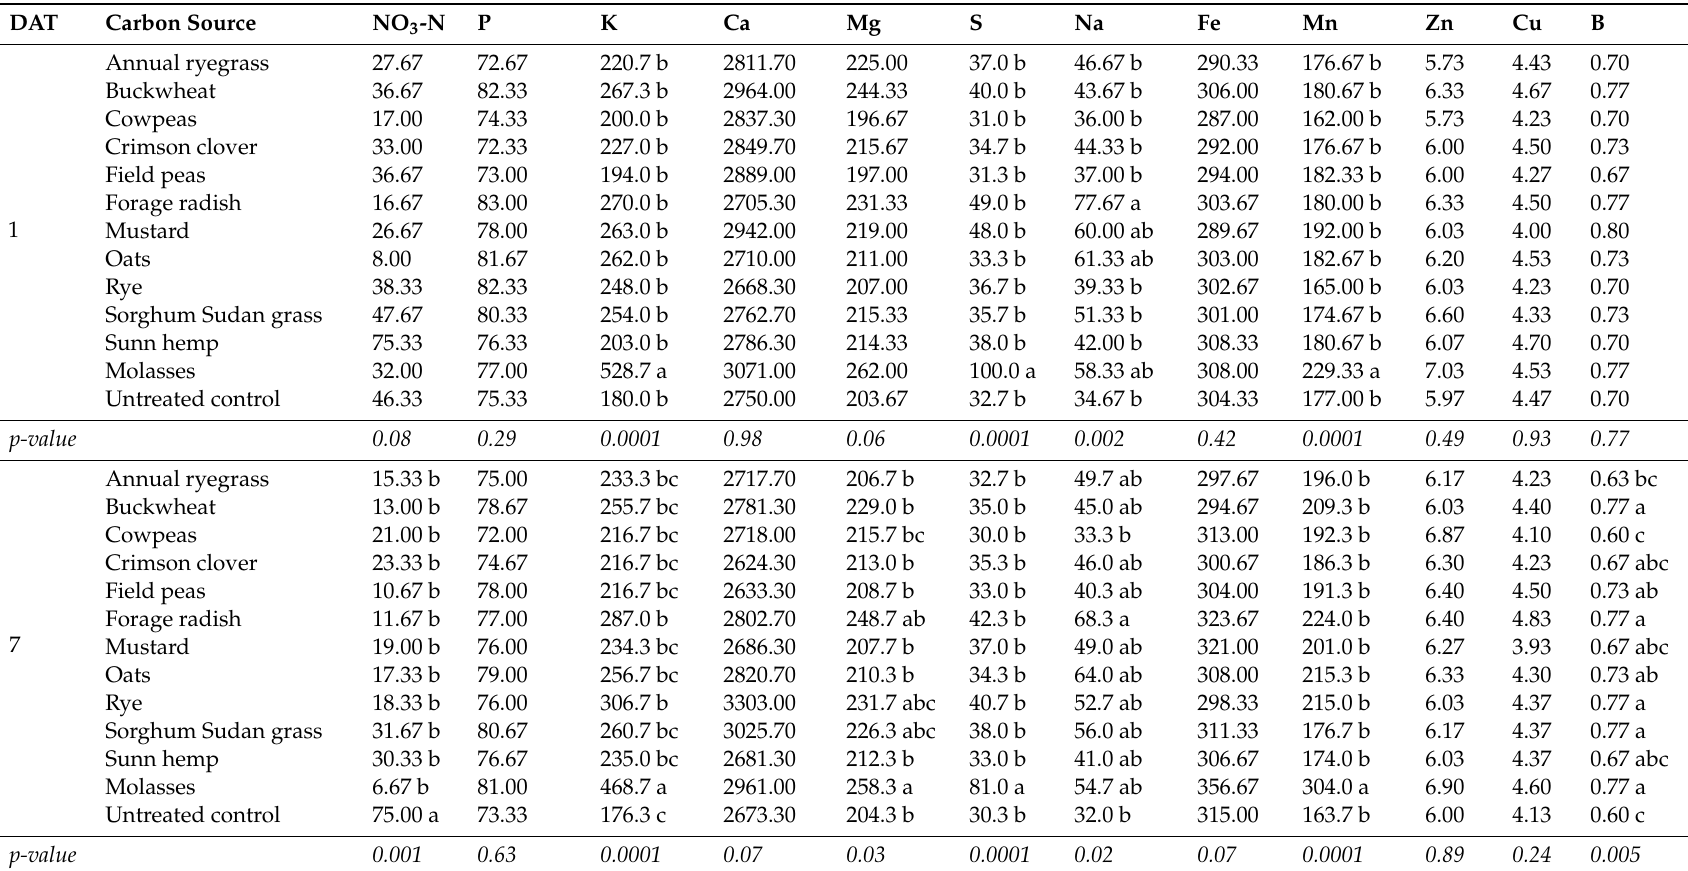
Table 6. Treatment e ff ect on soil mineral content (mg kg -1 ) at 1, 7, and 28 days after treatment (DAT) application 1